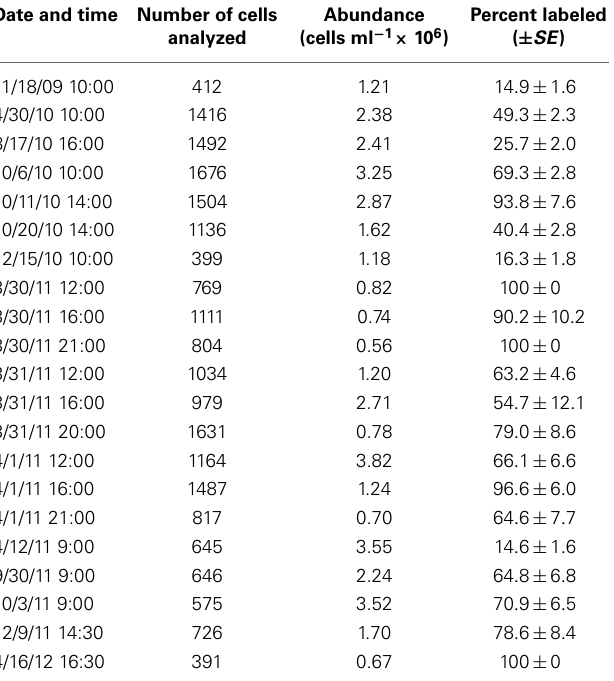
Table 2 | Overview of HPG percent labeling for 21 sampling dates at Scripps Pier.